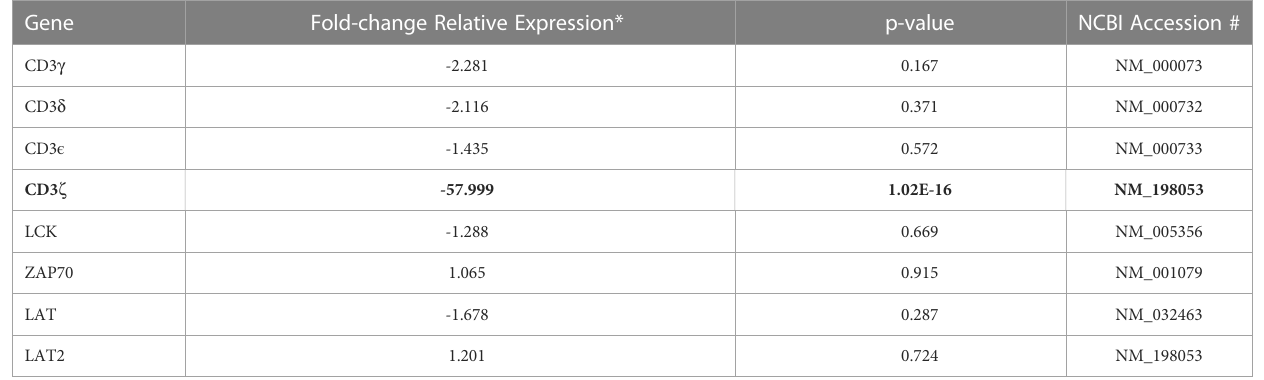
*Negative fold-change values represent genes with higher relative expression in V d 2 T